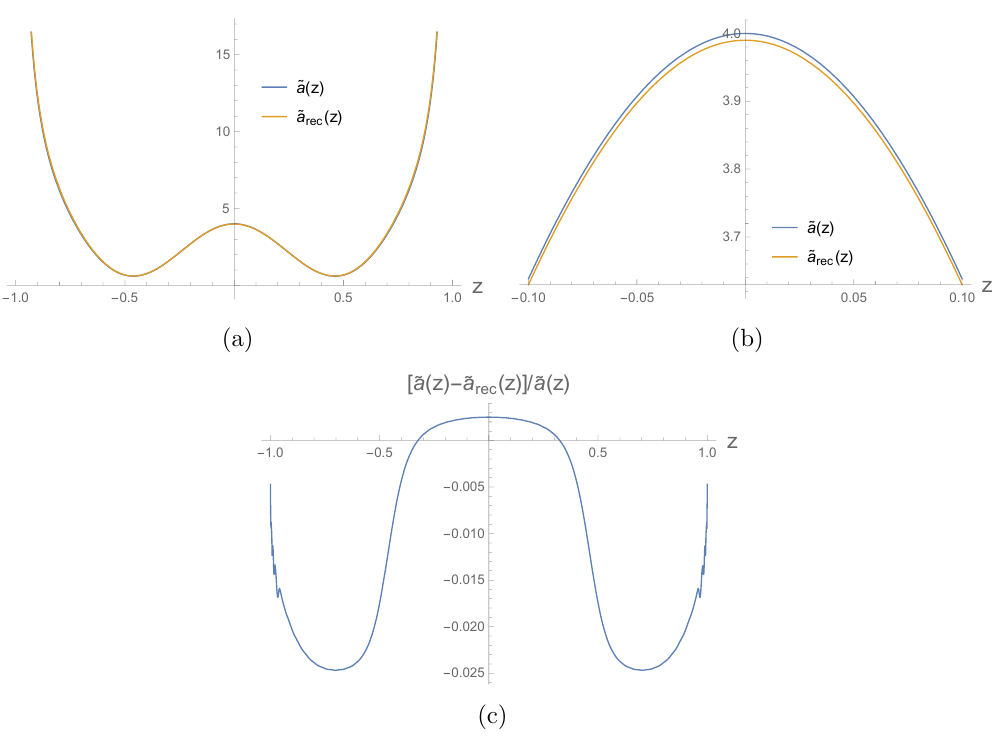
Figure 4. True scale factor ˜ a ( z ) (given by equation (3.54)) and reconstructed scale factor ˜ a rec ( z ) as a function of z . (a) The scale factors are almost indistinguishable at large scales. (b) Detail around the center of the wormhole at z = 0 . (c) Discrepancy between the true scale factor and the reconstructed scale factor, quantified by [˜ a ( z ) − ˜ a rec ( z )] / ˜ a ( z ) . As expected, the reconstruction is accurate up to corrections of order 1 /j max ∼ 10 − 2